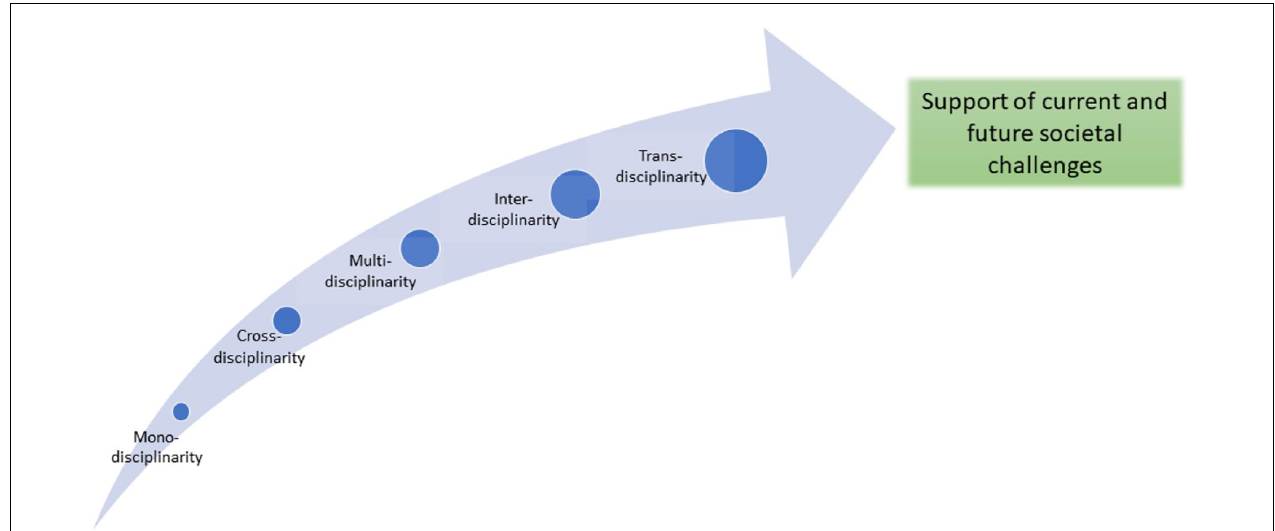
FIGURE 1 | Illustration of the variation of interdisciplinary teaching and learning methods and their contribution to societal needs. Source: The